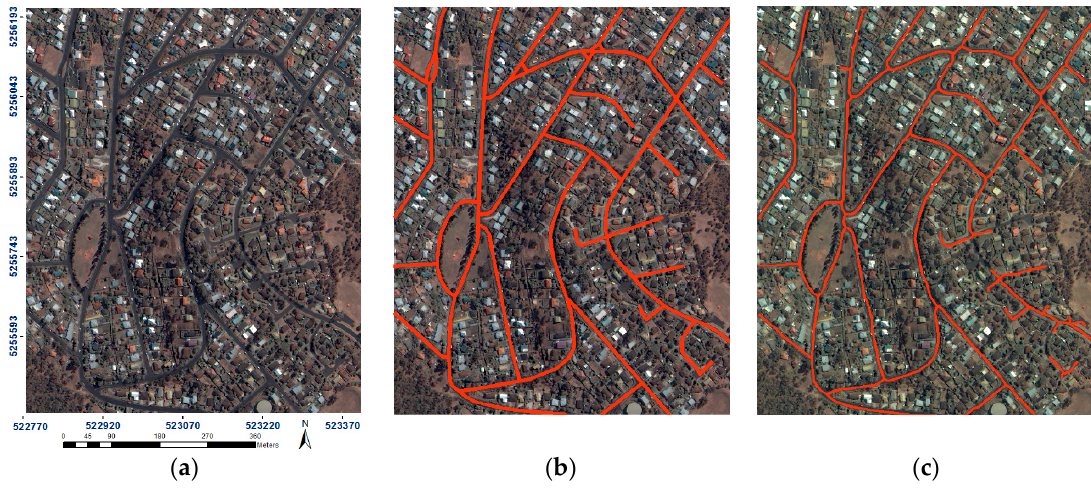
Figure 9. Third study area: ( a ) Input image; ( b ) Ground truth data; ( c ) Result of proposed method.